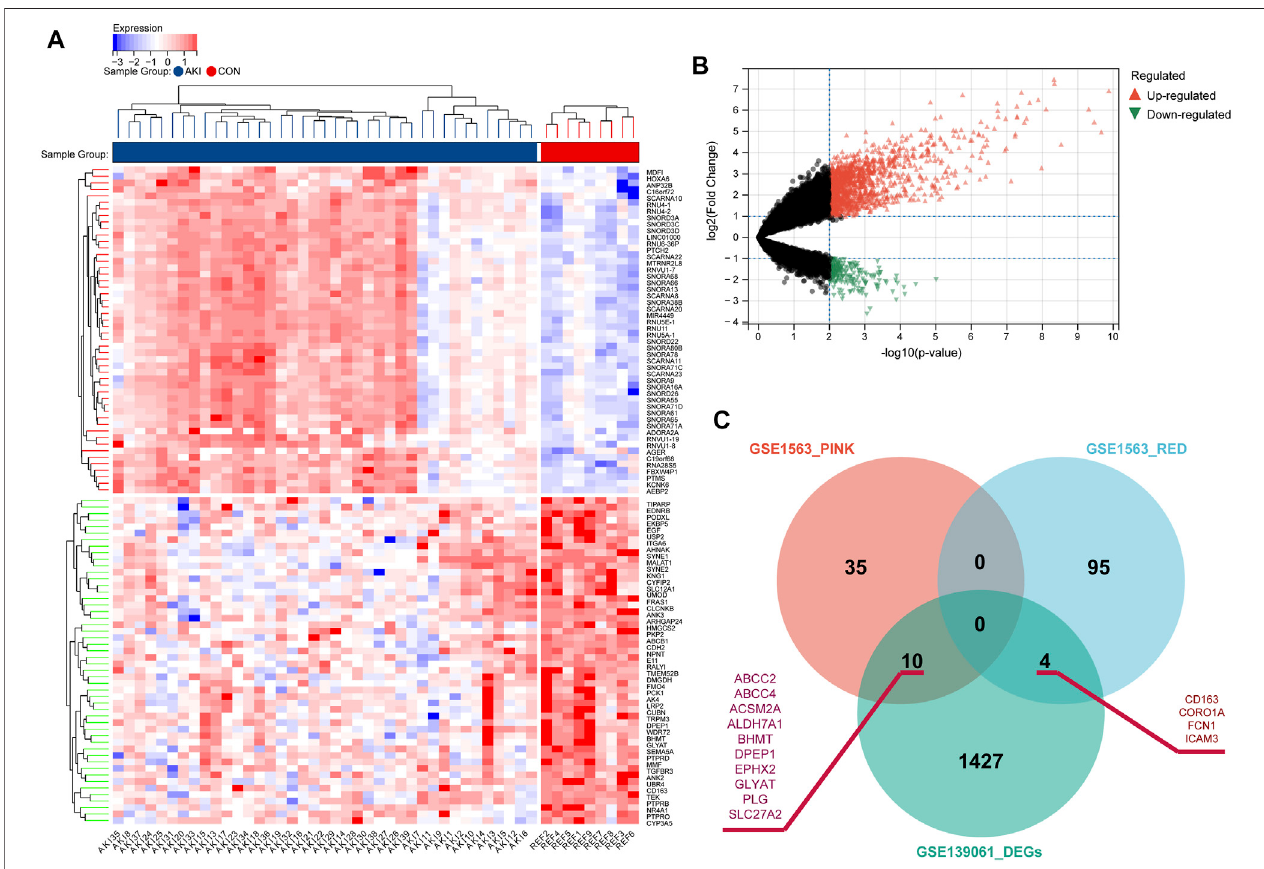
FIGURE 5 | Identi fi cation of the differentially expressed genes in AKI patients based on GSE139061 and screening of key genes. (A) Heatmap of top 50 upregulatedand50downregulated differentiallyexpressedgenesfromAKIandREFgroups. (B) VolcanoplotoftheDEGs. (C) Vennplotdepictstheoverlapof14genes identi fi ed in both DEGs from GSE139061 and genes in SCr-related modules from GSE1563, which are de fi ned as RFRGs (renal function-related